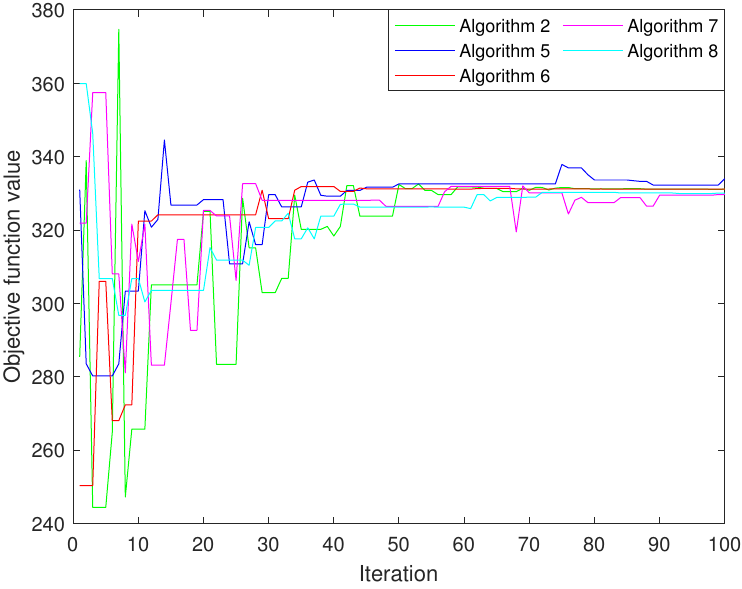
Figure 8. Comparsion of algorithms in 4 dimensions.